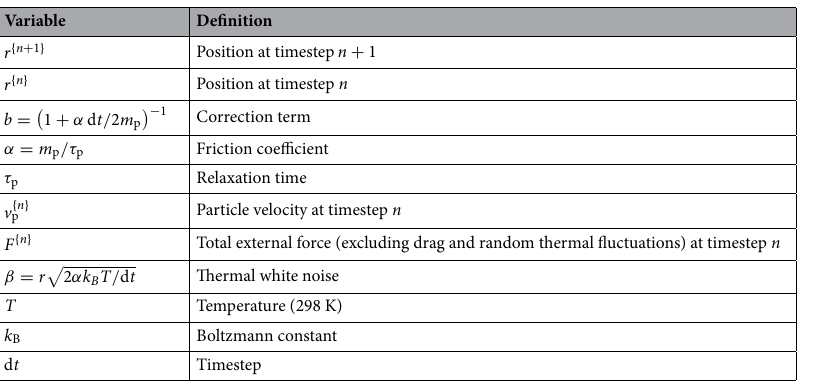
Table 2. Definition of all variables used in the optical trapping